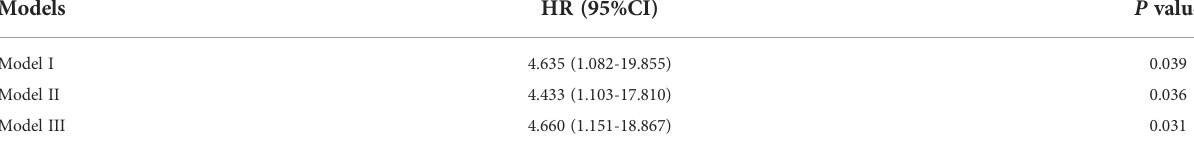
TABLE 3 Multivariate Cox regression models for the primary composite outcome.